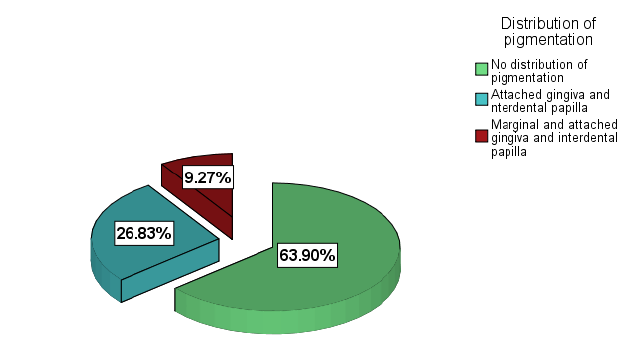
Figure. 2: Distribution of Pigmentation among participants Concerning the area of pigmentation, the results ranged from 63.9% who had no area of pigmentation to just 0.12% who had pigmentation in the lower right second premolar-to-premolar, with these and the remaining percentages shown in Figure (3).